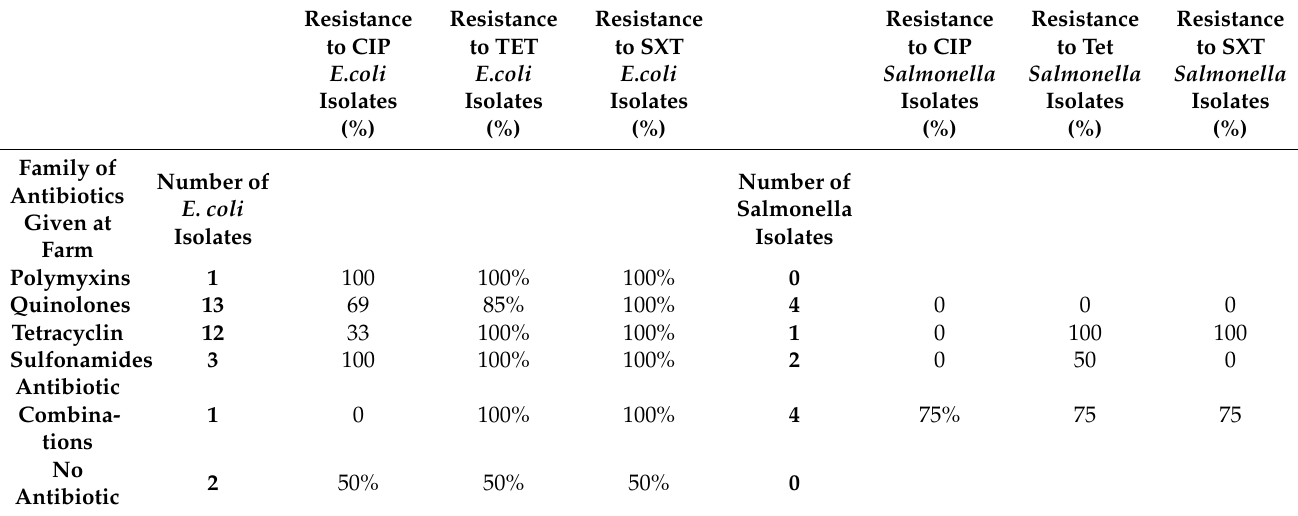
Table 4. Antibiotics given at farms in relation to resistance patterns in E. coli and Salmonella